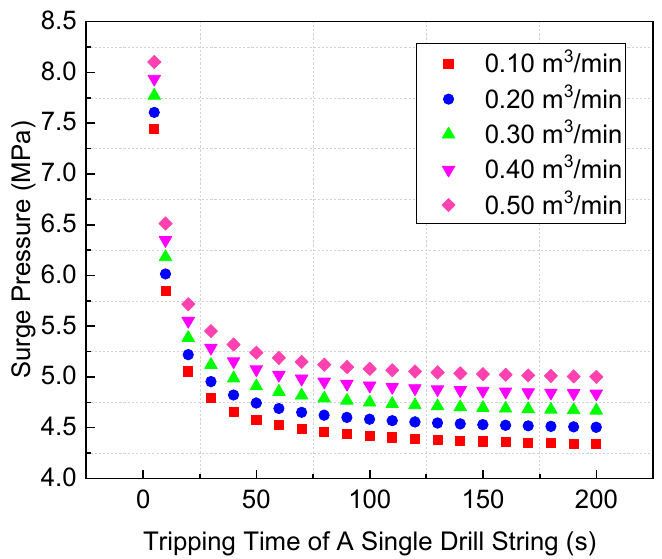
Figure 20. Variation of surge pressure with tripping time of a single drill string.